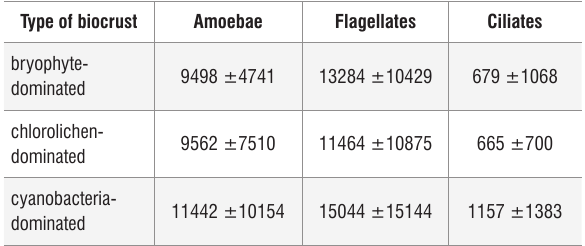
Mean (± s.d. ) heterotrophic protist abundance per gram dry weight of substrate in the three ( n =5) tested types of